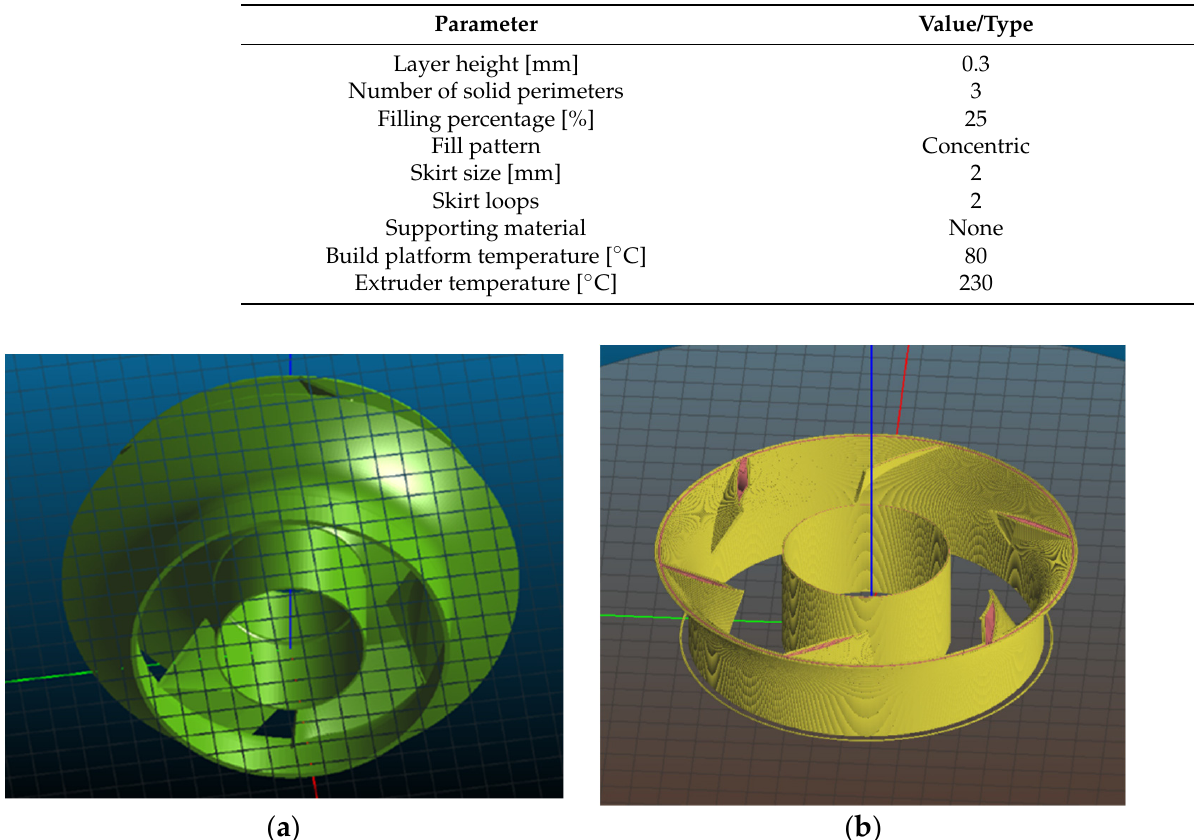
Table 5. Printing parameters set in Slic3r software for the realization of the concept model made of PET with the 3D FDM-based printer AnyCubic—Predator Delta.